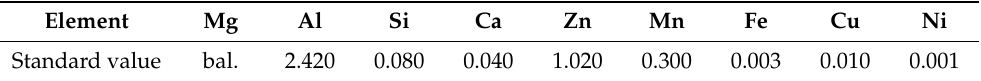
Table 1. Chemical composition of AZ31B magnesium alloy sheet (wt%. mass fraction).